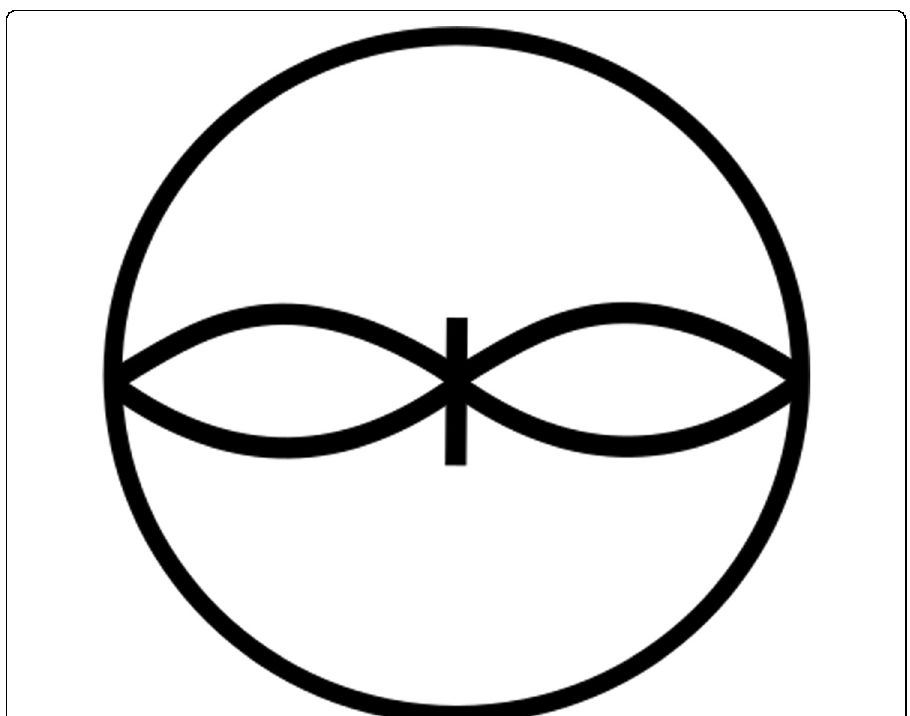
Fig. 21 Legend: In both bows, one (bended) line illustrates data of ‘ past ’ achievements while the line back illustrate a path of ‘ future ’ steps. One bow presents statistics of personal paths, the other of the aggregate learning audience. The vertical line illustrates how data visualizations work to mirror